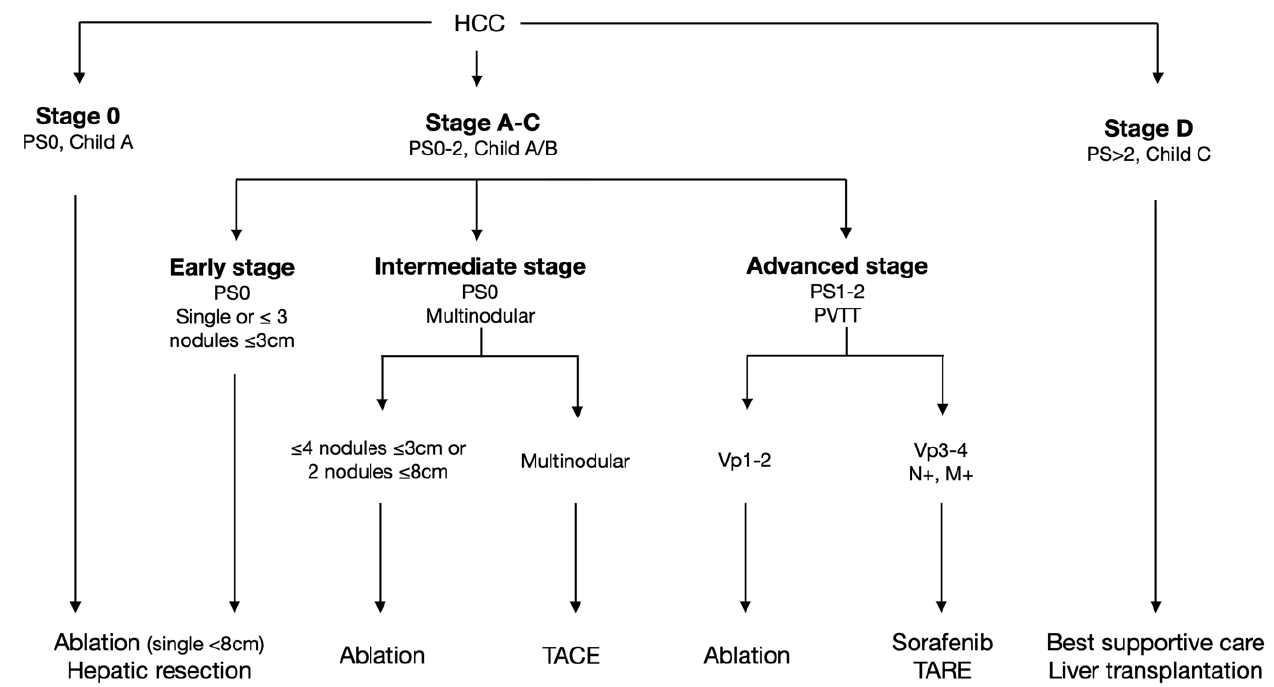
Figure 1. Protocol for the management of hepatocellular carcinoma in cirrhotic patients applied at Jean Verdier Hospital University (Bondy group) in first-line setting. Ablation techniques used at Jean Verdier Hospital are monopolar radiofrequency, multi bipolar radiofrequency, microwave, in- tra-arterial ethanol injection and irreversible electroporation [15,16]. Large ablation with multi bi-